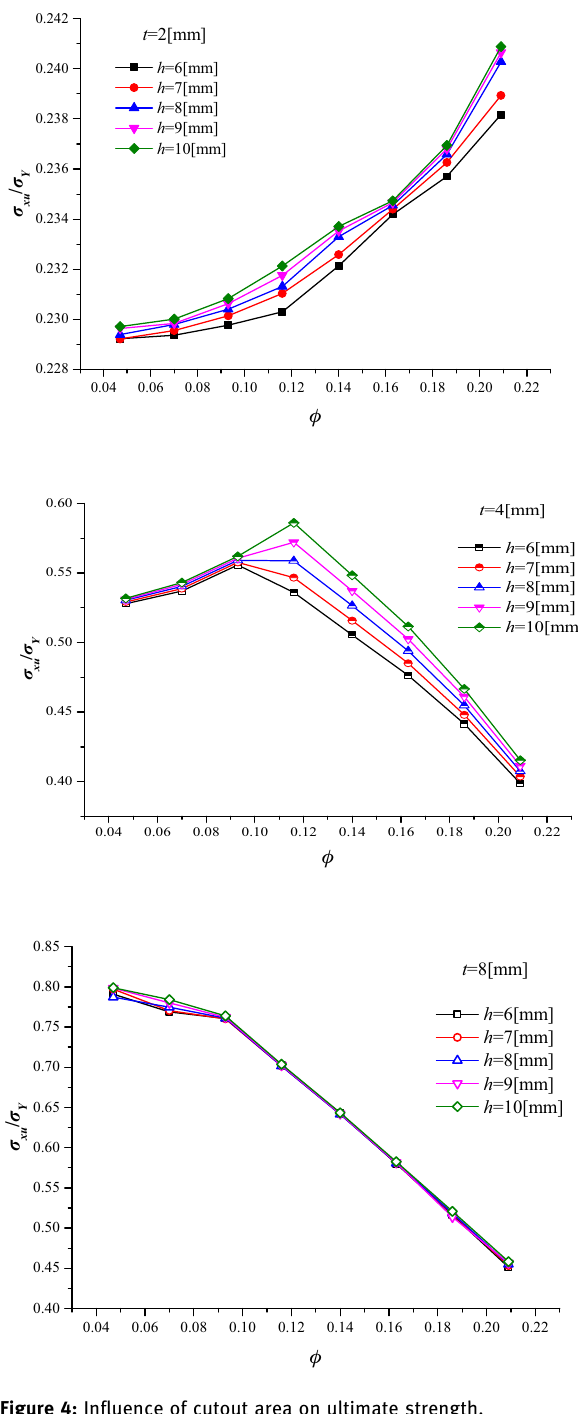
Figure 4: In fl uence of cutout area on ultimate strength.